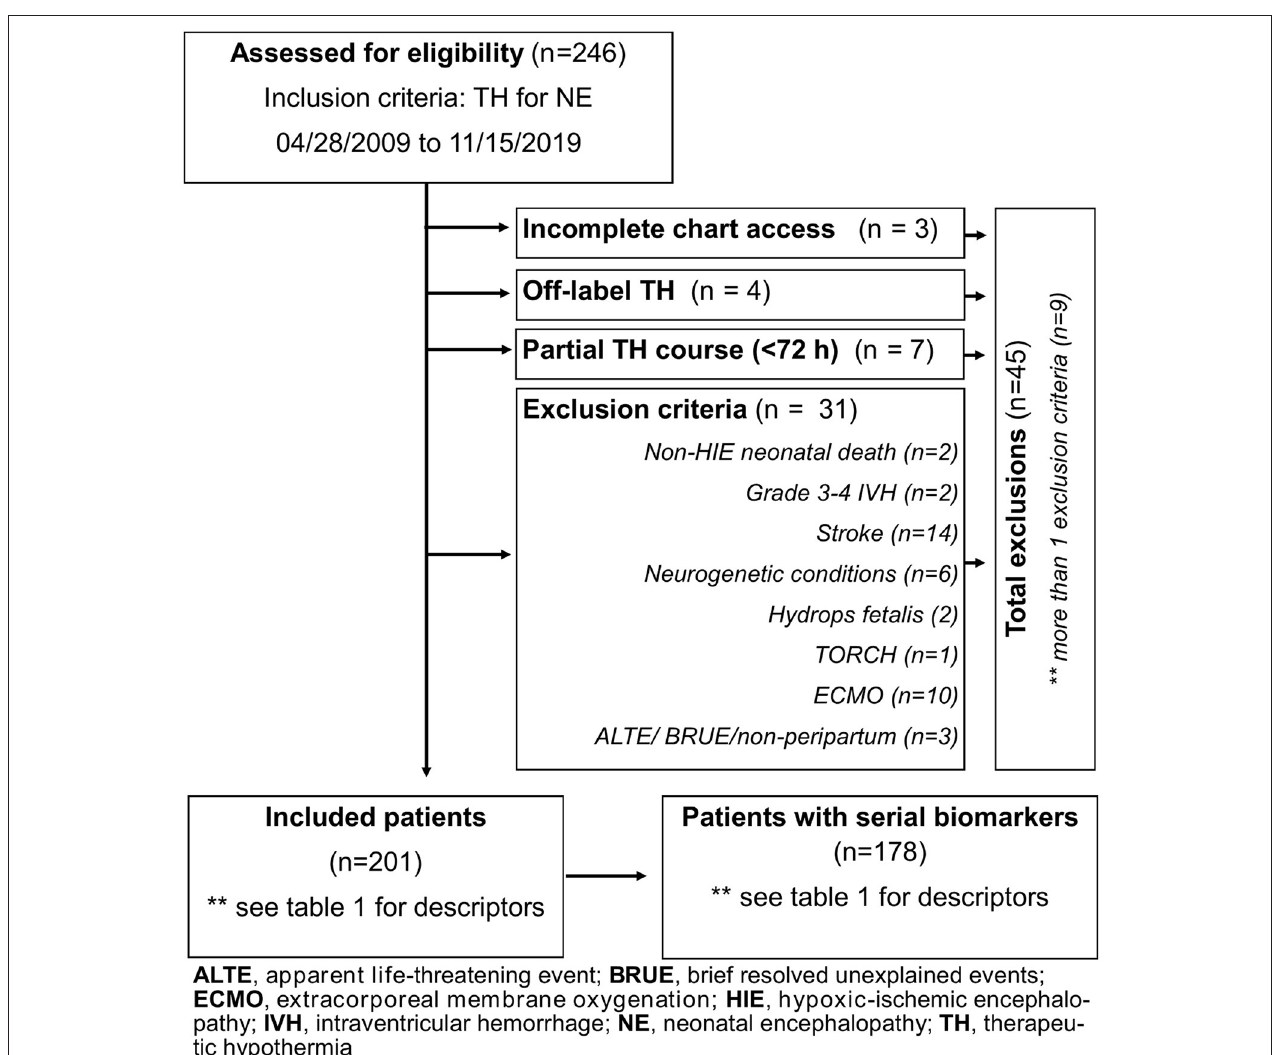
FIGURE 1 | Flowchart of patient